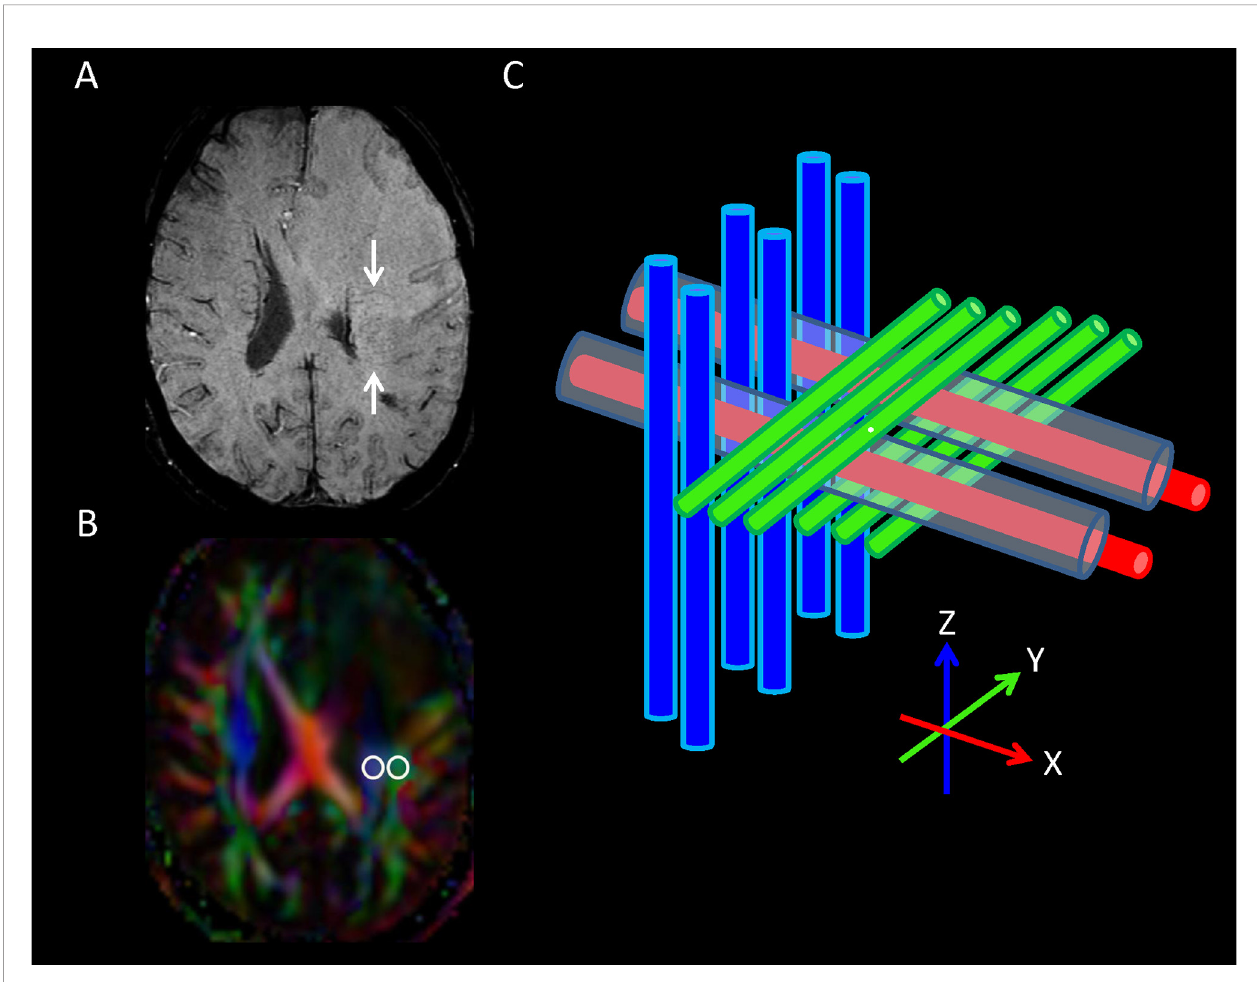
FIGURE 2 | (A) On transverse susceptibility-weighted image, the deep medullary veins (arrows) run in the right – left direction (x-axis) at the level of the lateral ventricle body. (B) Directionally encoded color map illustrates the regions of interest of projection (blue area) and association (green area) fi bers in the left periventricular region for calculation of analysis along the perivascular space ALPS index. (C) Schematic diagram presenting the relationship between the directions of the perivascular spaces (gray cylinders) surrounding the deep medullary veins (red cylinders; x-axis), the projection fi bers (blue cylinders; z-axis), and the association fi bers (green cylinders; y-axis). Note that the direction of the perivascular spaces is perpendicular to both the projection and association fi